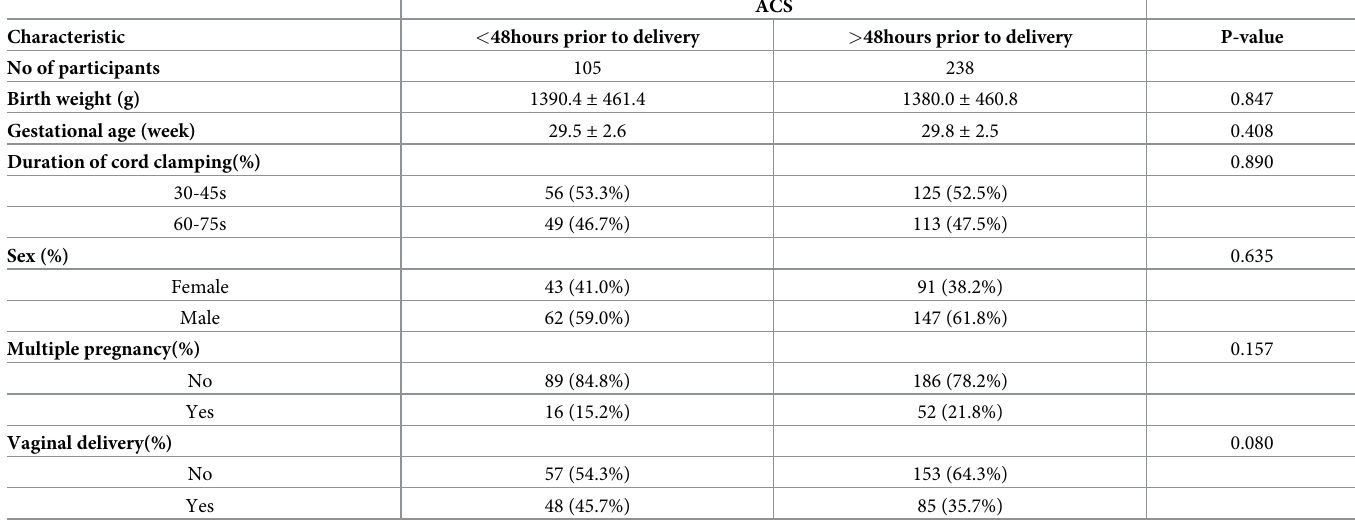
Table 1. Baseline characteristics of participants (N =